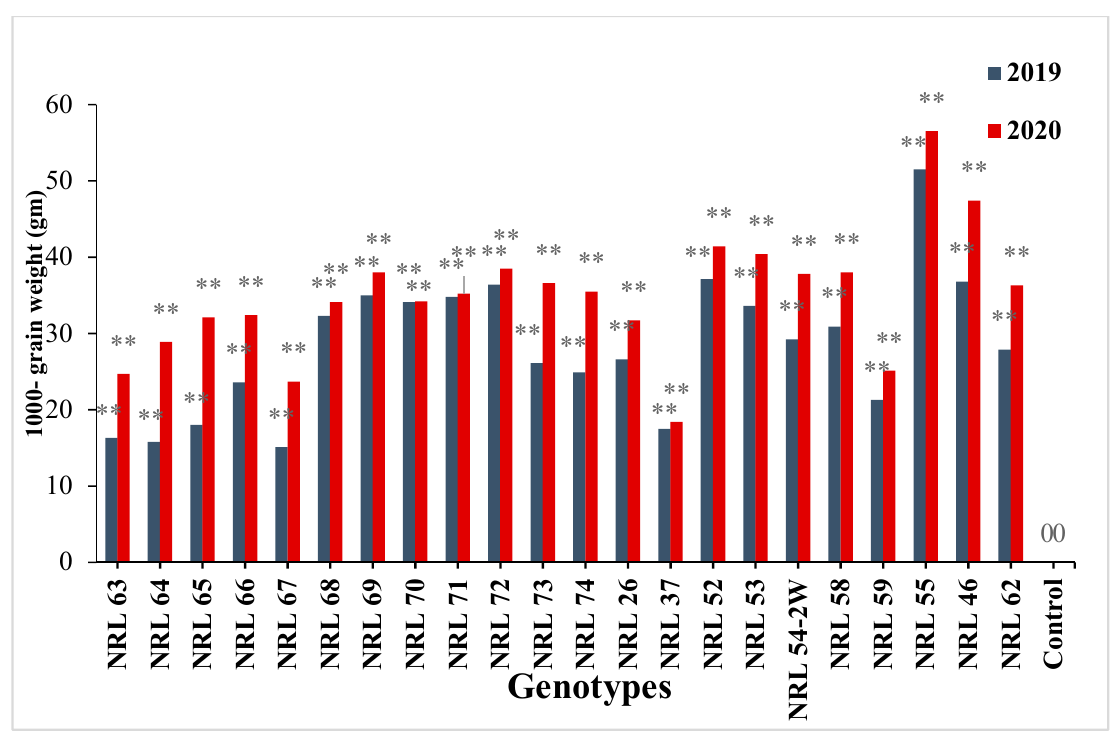
Figure 8. The percentage of advantage over commercial variety for panicle weight of studied geno- types during the 2019 and 2020 growing seasons. Means **: Highly significant at 1%; *: Significant at 5%; ns: Non-significant.